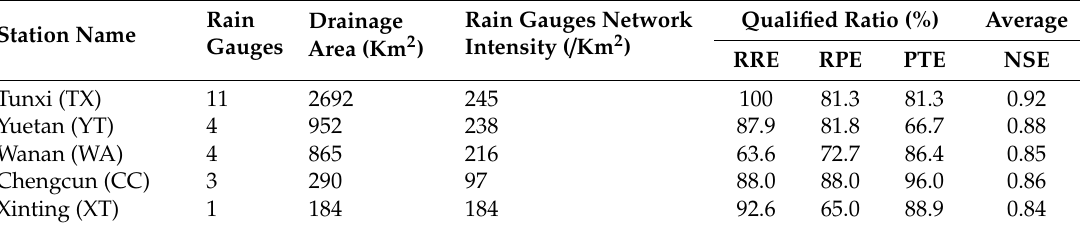
Table 4. Accuracy statistics of the improved model simulations for both calibration and validations